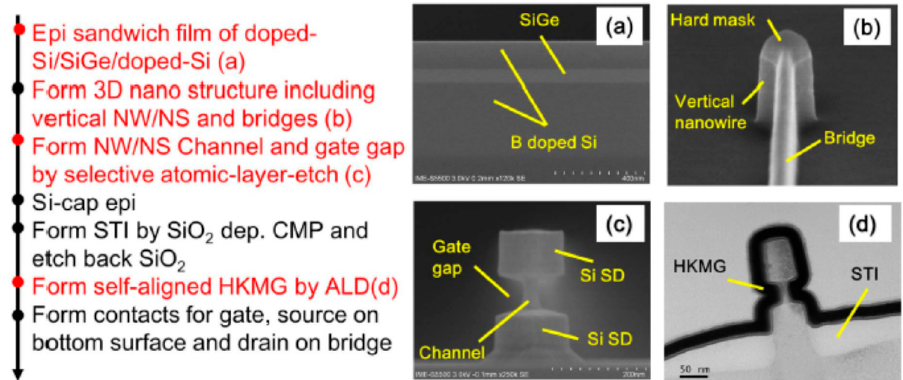
Figure 7. Process flow for vertical sandwich GAAFET (VSAFETs): ( a ) SEM after Si/SiGe/Si, ( b ) SEM tilt image of the 3D nanostructure after Reactive ion etching ( c ) SEM after quasi-atomic layer etching (QALE), and ( d ) TEM after high-k and metal gates (HKMG) deposition [46].